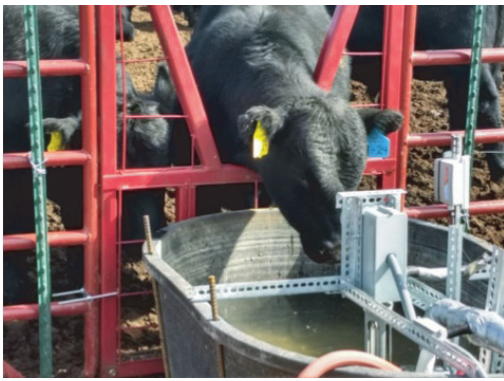
Figure 5. Drinking station with a cow drinking from the trough.